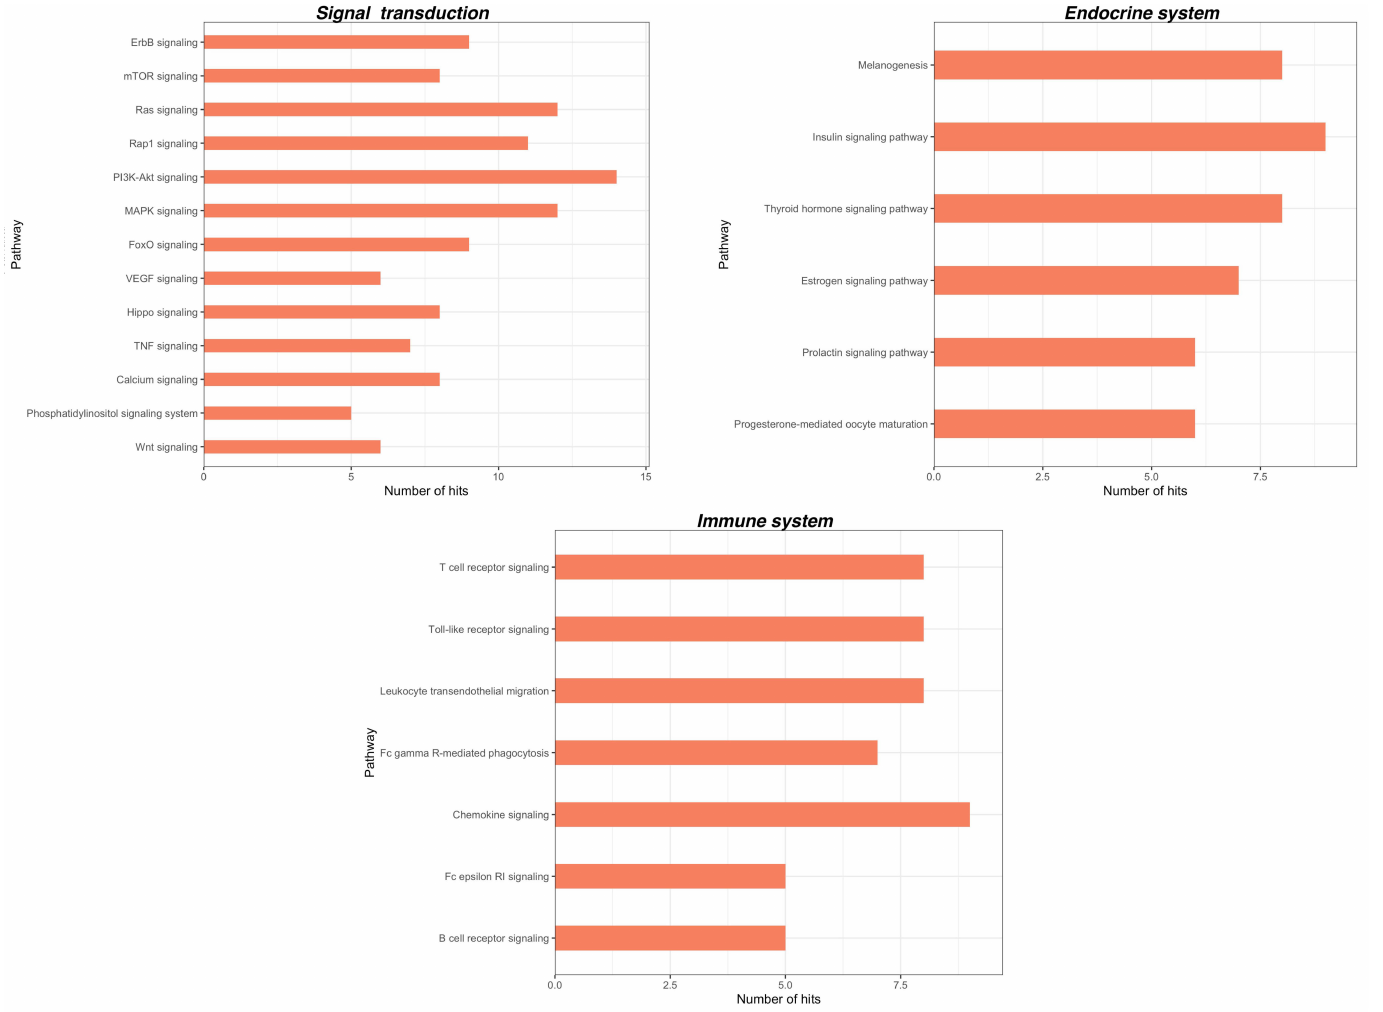
Figure 3. KEGG pathways related to cellular processes significantly associated with miRNA targets in CSP (within each group, pathways are arranged according to their p-values, in descending order). Adjusted p -values were calculated using Benjamini-Yekutieli method.